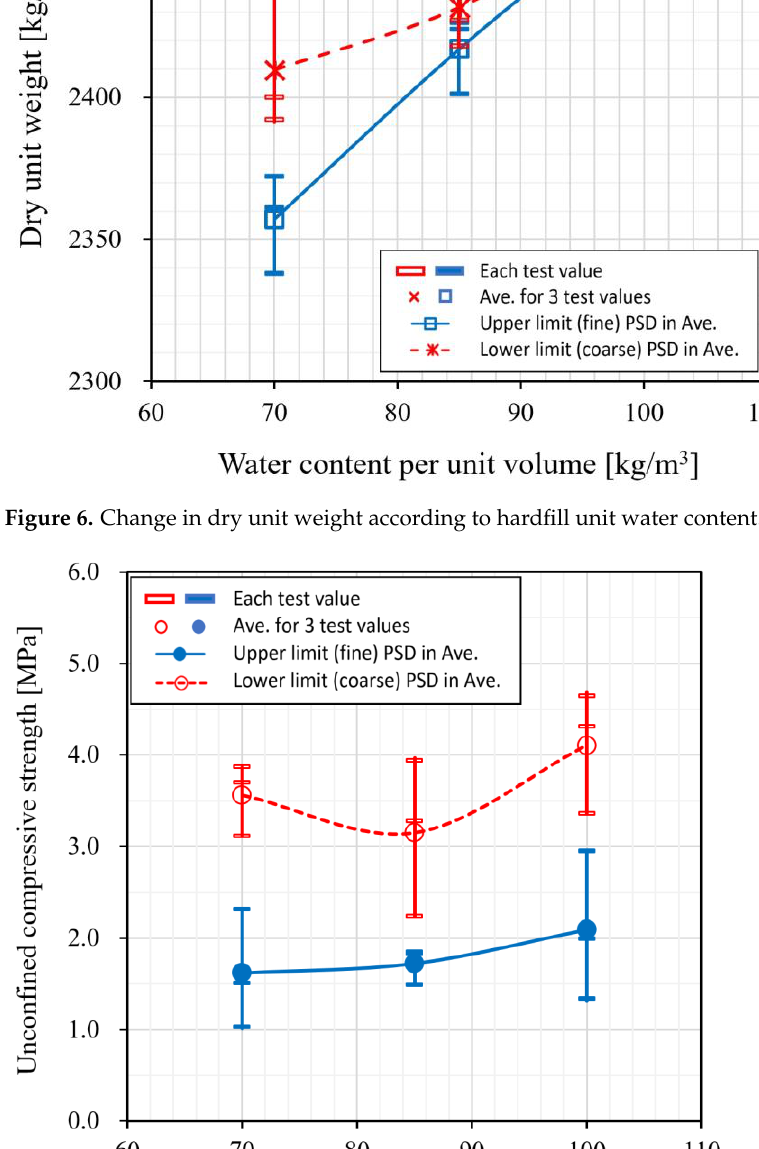
Figure 7. Change in hardfill ’ s uniaxial compressive strength according to unit water content.